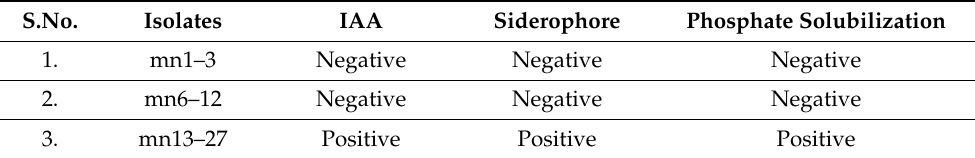
Table 1. Enzymatic characterization of the Bacillus isolates.